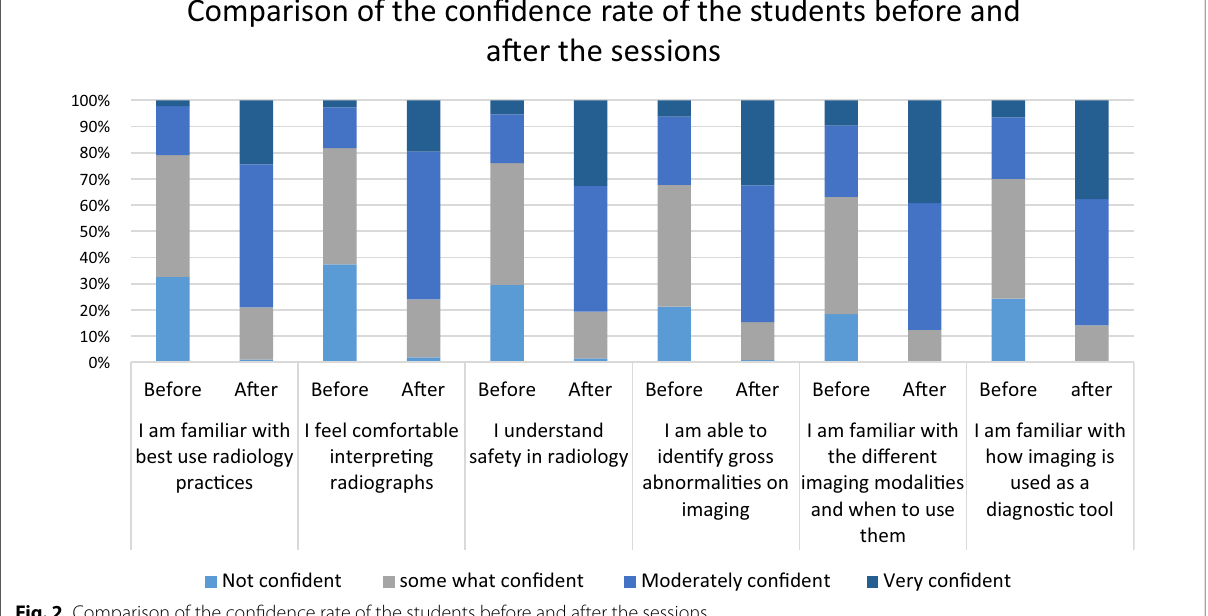
Fig. 2 Comparison of the confidence rate of the students before and after the